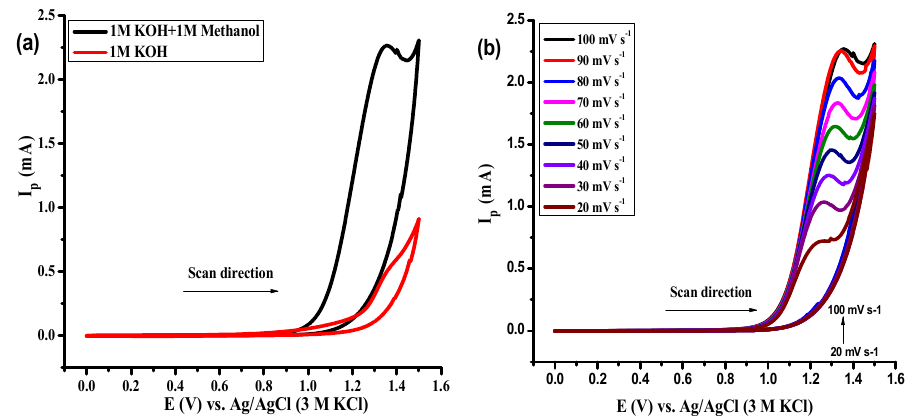
Figure 4. Cyclic voltammograms for equiatomic HEOs; (Fe, Al, Mg, Cd, Cr, Mn) 3 O 4 in 1M KOH with and without methanol ( a ) and (Fe, Al, Mg, Cd, Cr, Mn) 3 O 4 at different scan rates from 20–100 mV s − 1 ( b ).